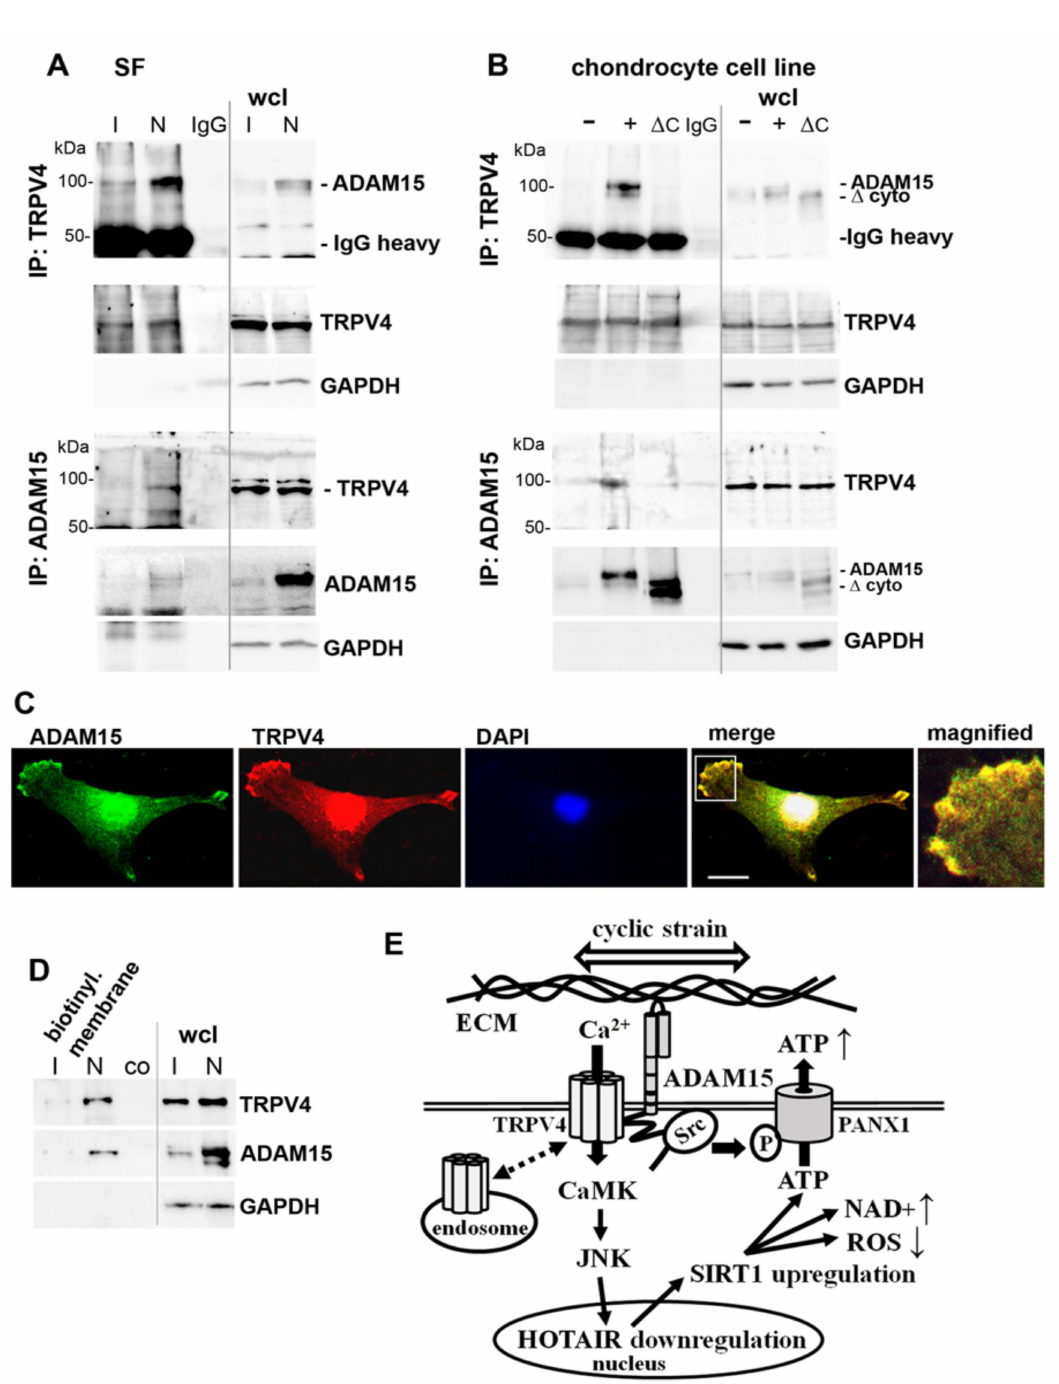
Figure 8. Interaction of ADAM15 with transient receptor potential vanilloid 4 (TRPV4) channel and colocalization in the cell membrane. ( A,B ) Immunoprecipitations (IP) of ( A ) SF with downregulated ADAM15 by siRNA (I) or non-silencing siRNA (N) and ( B ) chondrocyte cell line transfected with full-length ADAM15 (+) or ADAM15 lacking the cytoplasmic domain ( ∆ C), using TRPV4 or ADAM15 antibodies, or IgG as control. GAPDH served as a loading control.